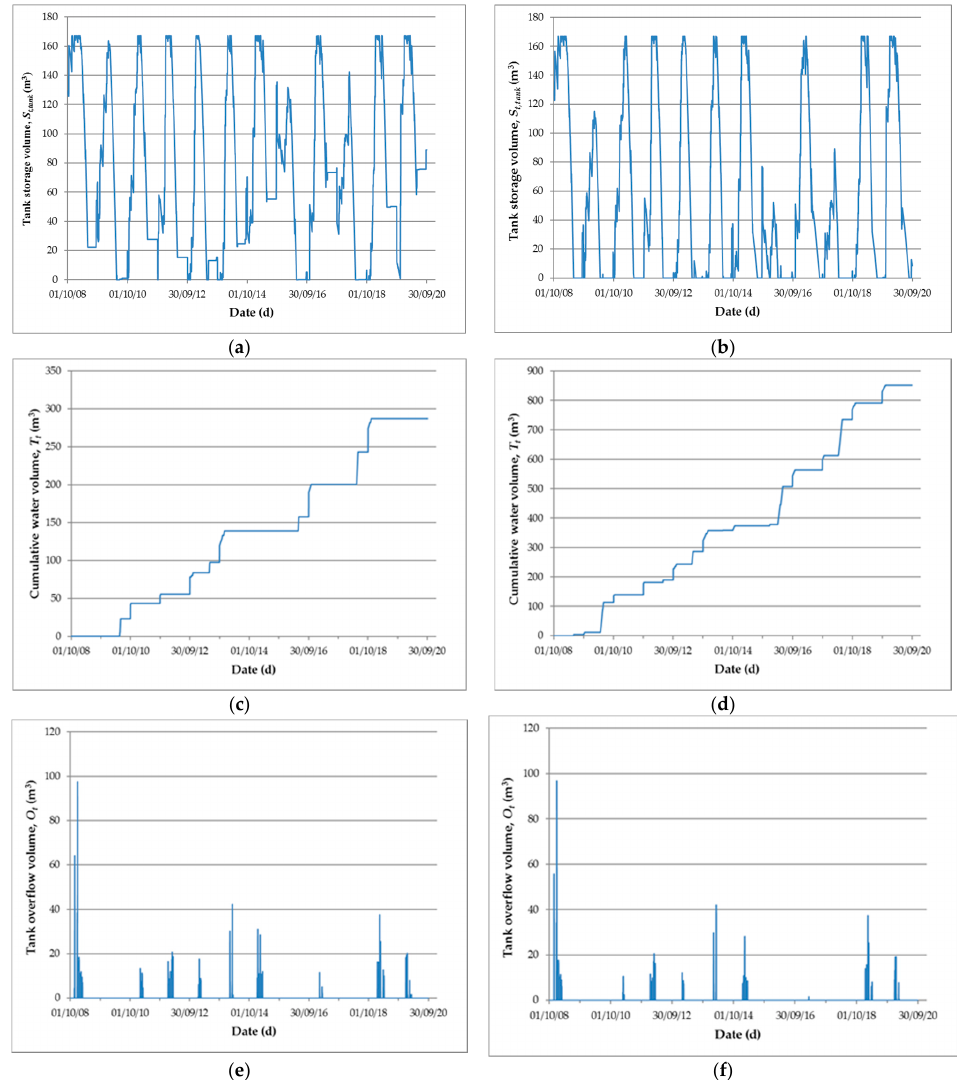
Figure 9. Stored water volume in covered ( a ) and uncovered tank ( b ); cumulative water volume supplied from other sources to meet the water needs of a tomato crop for covered ( c ) and uncovered tank ( d ); and overflow water volume from covered ( e ) and uncovered tank ( f ) as computed by applied the daily water balance method for tank size V tank = 167 m 3 and collection area A = 1000 m 2 .